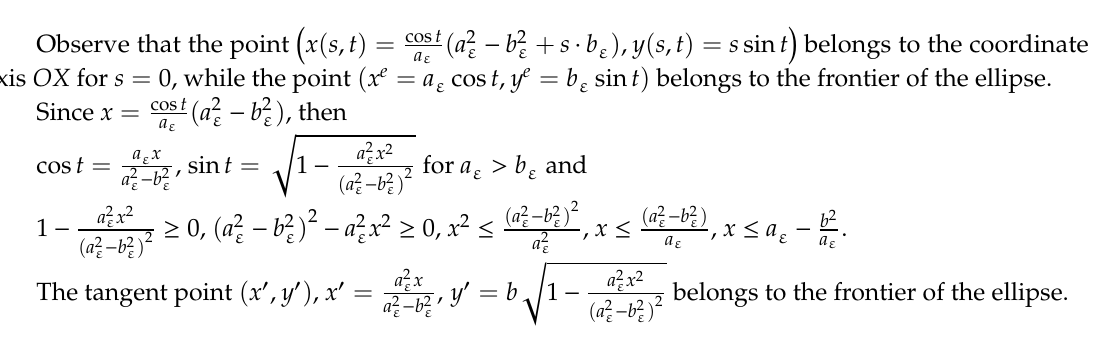
Figure 9. The optimized cover of the spheroid E by